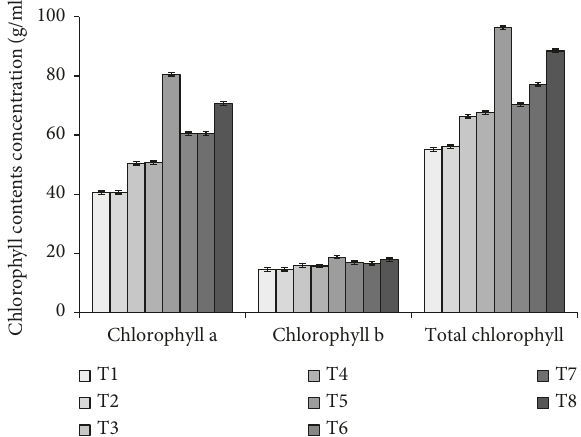
Figure 2: Influence of different organic and inorganic fertilizer regimes on chlorophyll contents (g/ml) of strawberry cv.